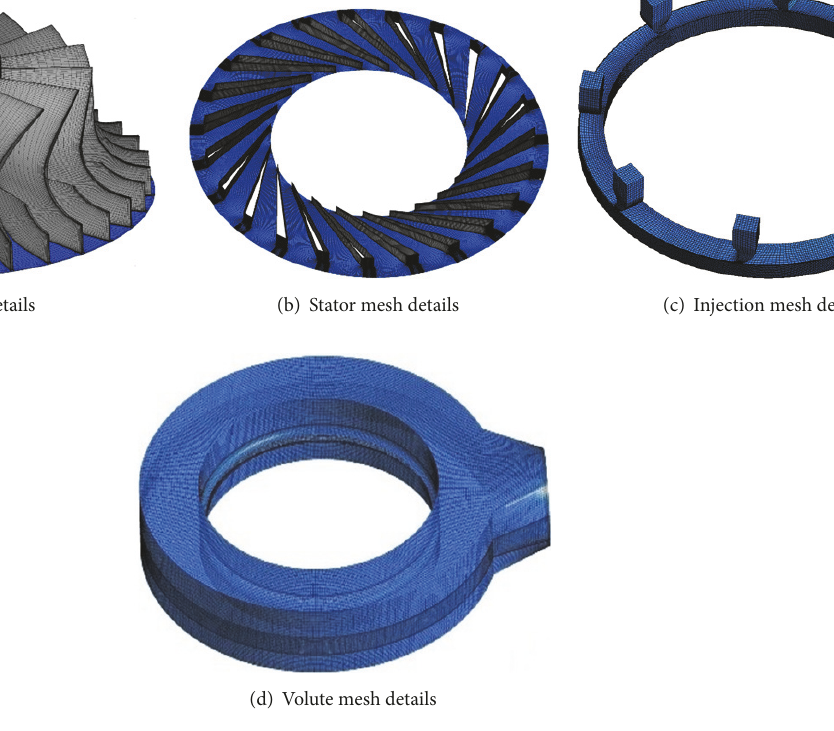
Figure 14: CFD computational grids.